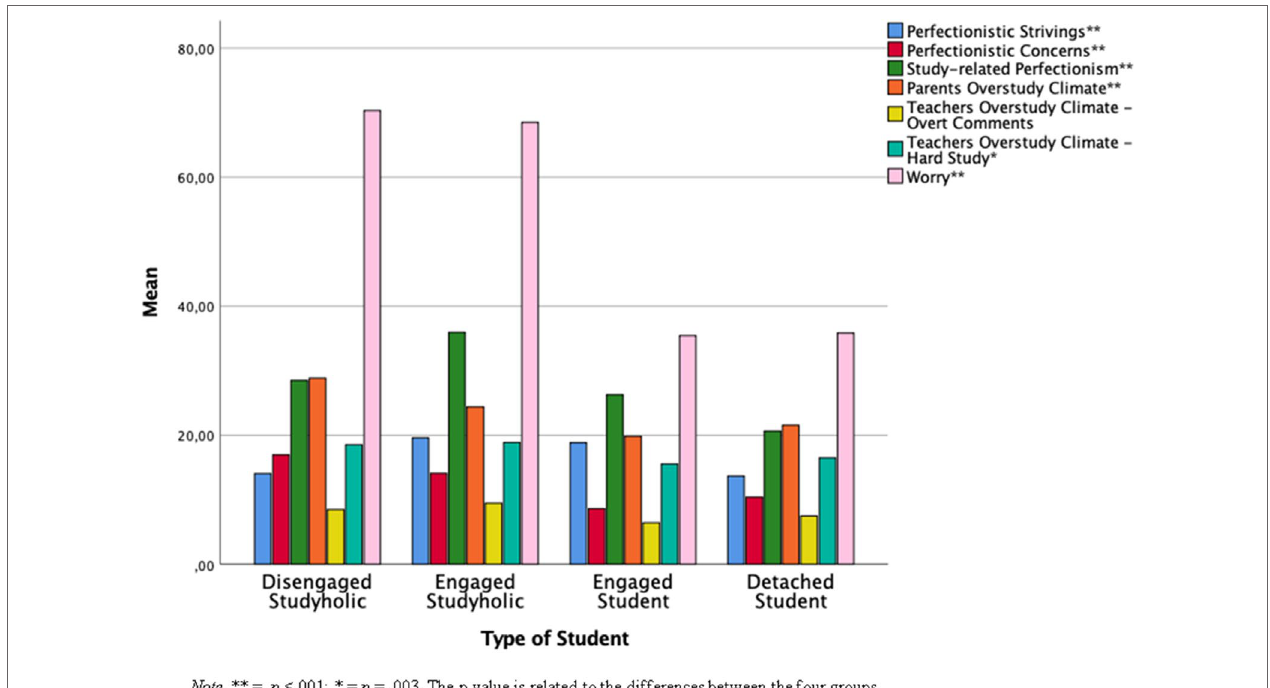
FIGURE 4 | Bar graphs representing the mean of the antecedents by the four groups of